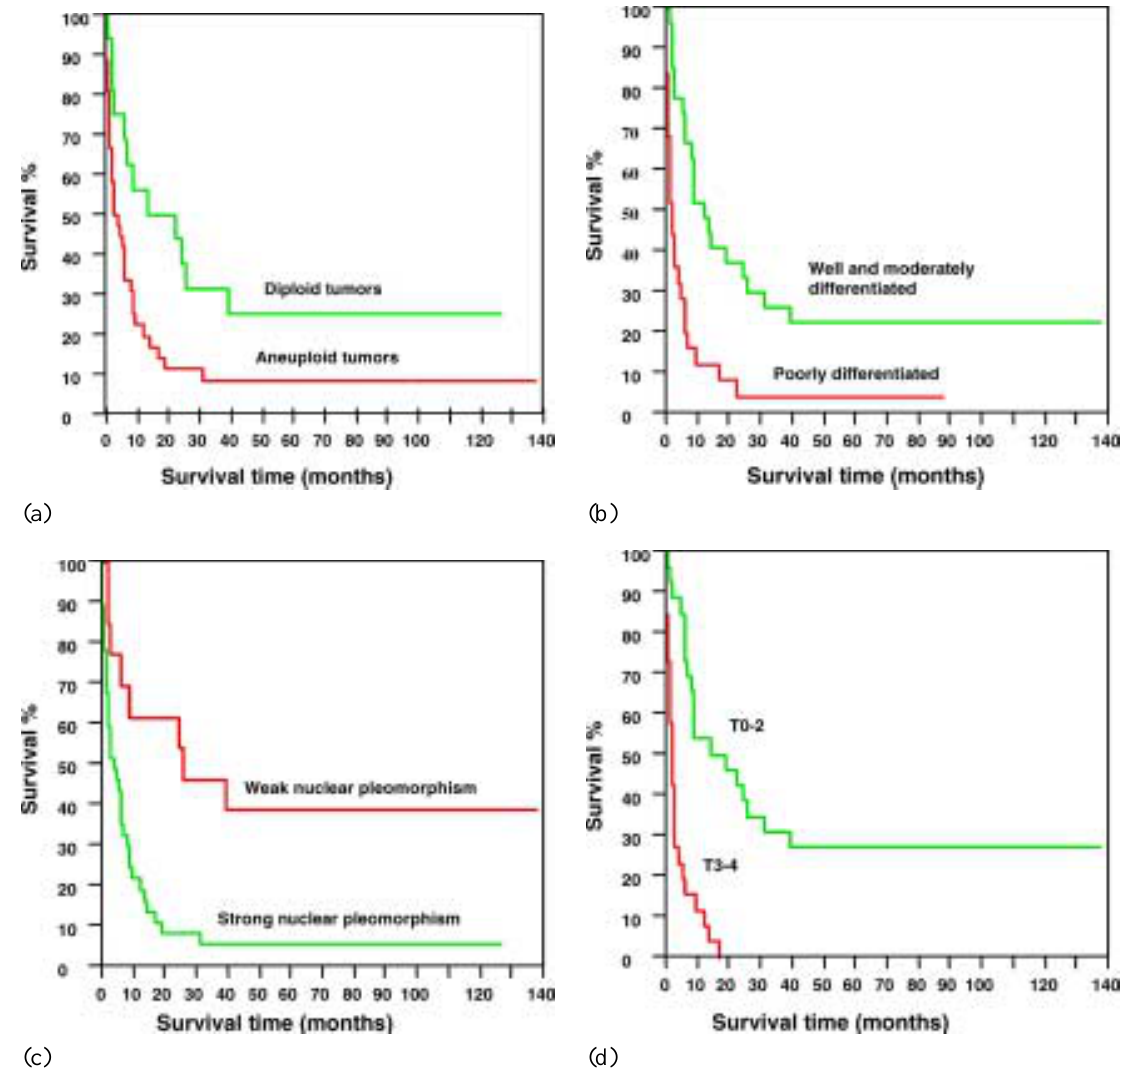
Fig. 4. (a) Tumour specific survival curves for patients in 36 aneuploid tumours and 16 diploid tumours ( p = 0 . 02). (b) Tumour specific survival curves for patients in 25 poorly and 27 well and moderately differentiated tumours ( p = 0 . 0001). (c) Tumour specific survival curves for patients in 13 tumours with weak and 37 with strong nuclear pleomorphism ( p = 0 . 004). (d) Tumour specific survival curves for patients in 26 tumours with T classification T0–2 and 26 with T3–4 ( p < 0 .